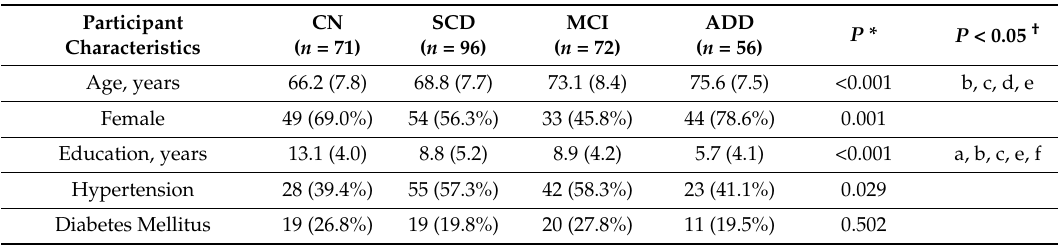
Table 3. Demographic and clinical characteristics according to the Alzheimer’s disease (AD) clinical